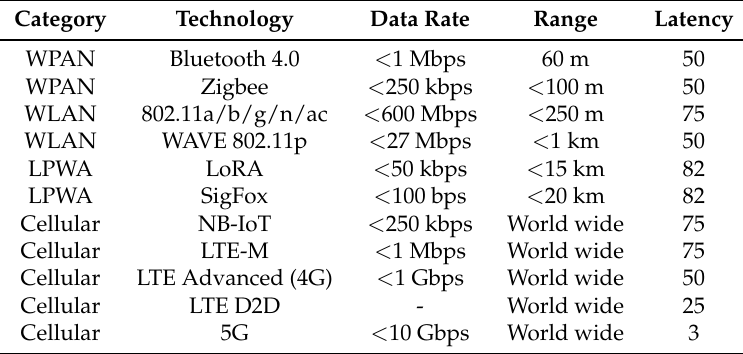
Table 1. Categories of communication technologies available to